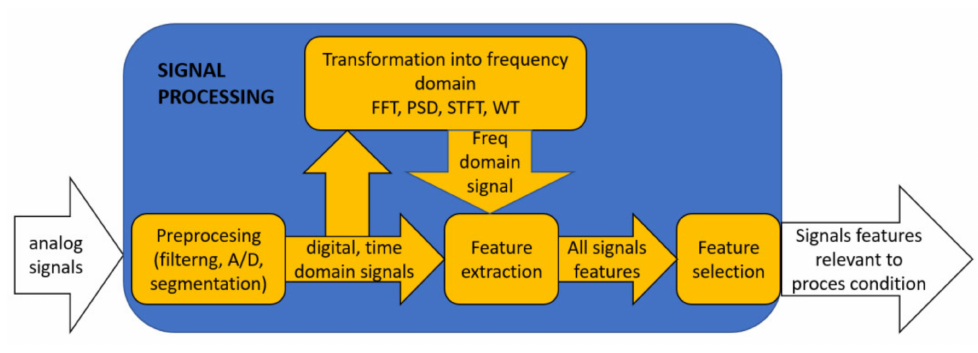
Figure 2. Signal processing logical